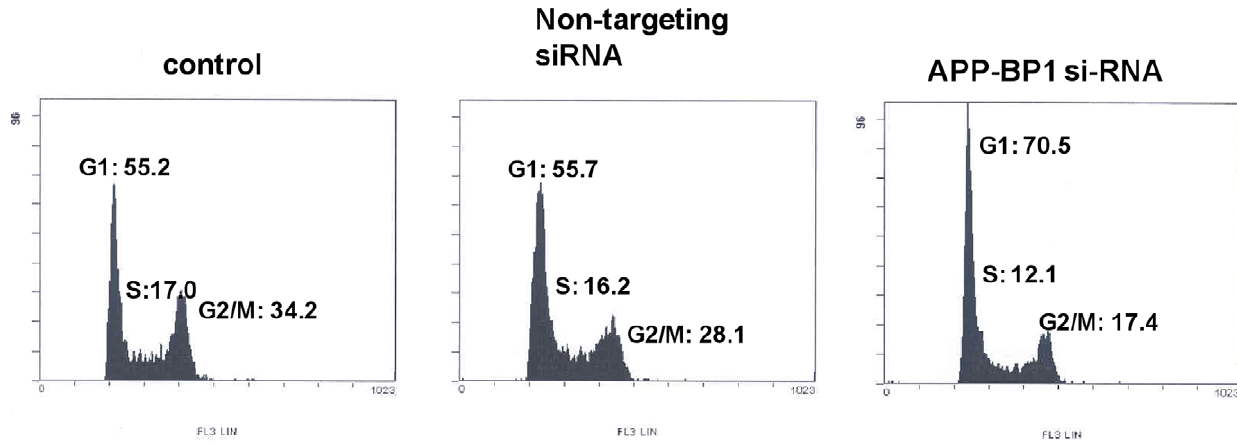
Figure 1. APP-BP1 knockdown arrests cell cycle at G1-phase in fetal neural stem cells. The DNA content of the siRNAs treated fetal neural stem cells (Passage 8) was evaluated by flow cytometry with a FACScan instrument. Each group represents the status of the cell cycle for 10,000 cells.